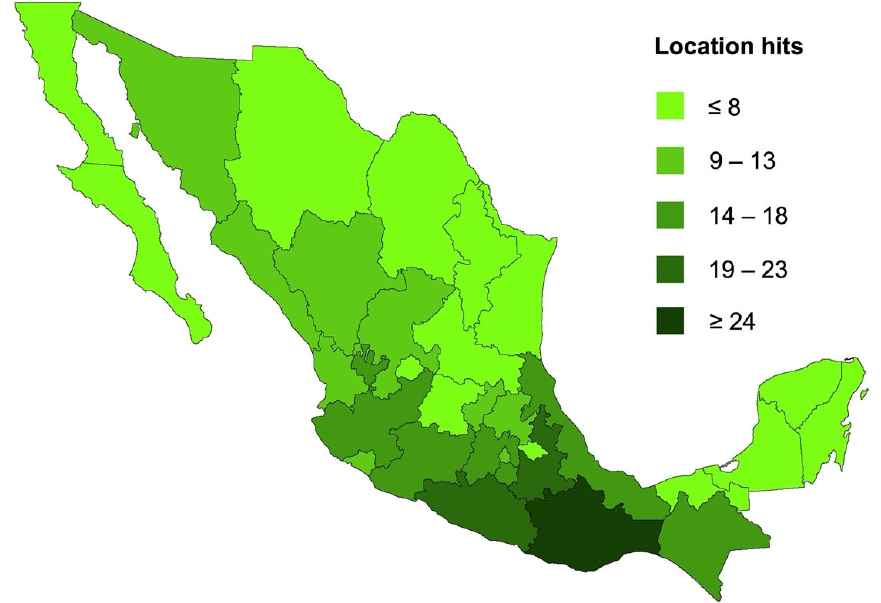
Figure 3. Geographical origin and distribution of Mexican plants as a source of PCTs with bioactivity according to published reports and distribution frequencies.